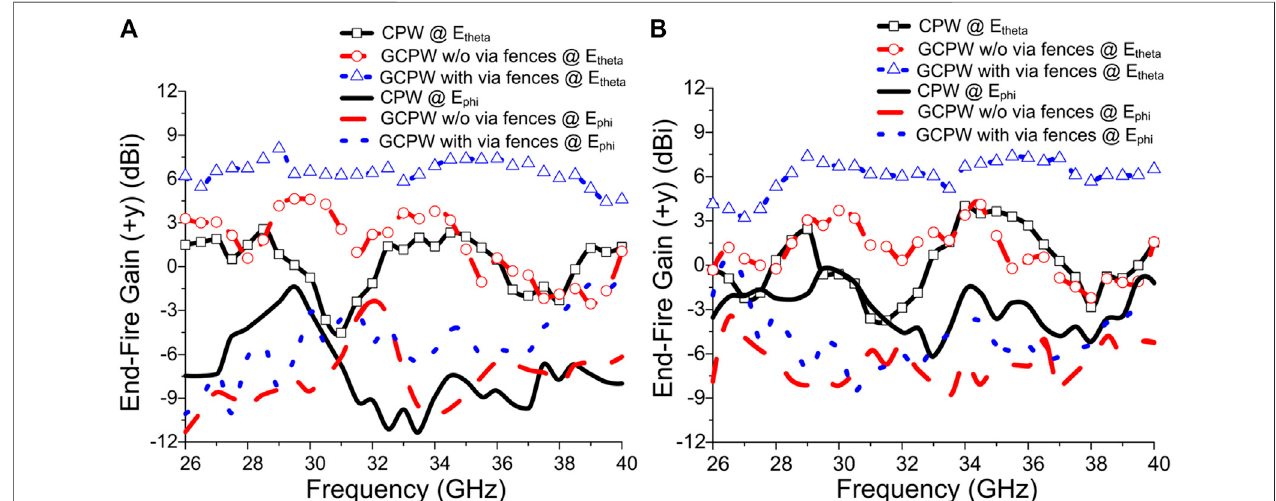
Frontiers in Communications and Networks |